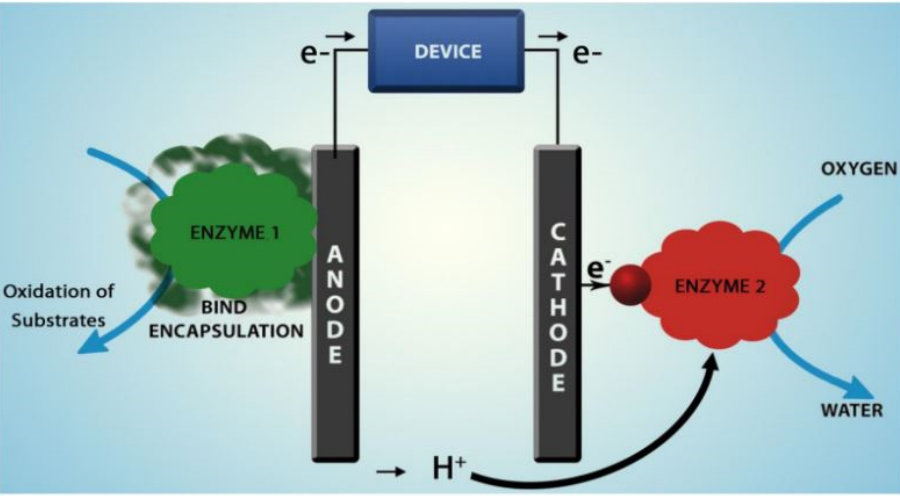
Figure 4. Membrane-less enzymatic fuel cell. Reproduced with permission from Ref. [71] .